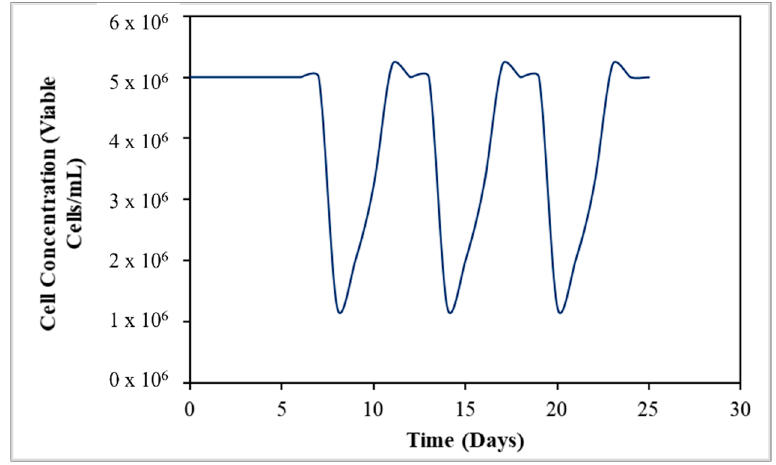
Figure 4. Semi-continuous bleed: The graph above shows the potential results of bleeding cells from a perfusion cell culture reactor to batch-mode wave bag reactors for viral production.